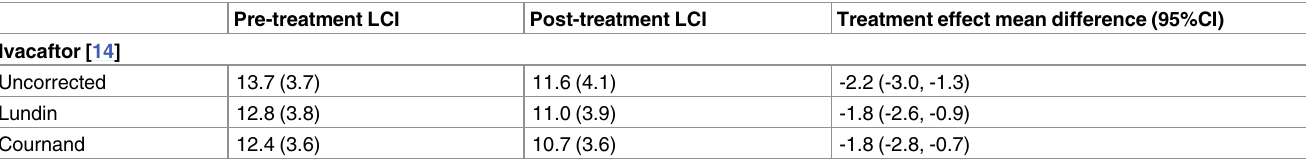
Table 5. Effect of applying Lundin and Cournand correction equations to previously published observational MBW data. Data are shown as pre- treatment and post-treatment LCI with pairedtreatment effect. Valuesare presentedas mean (SD) unless